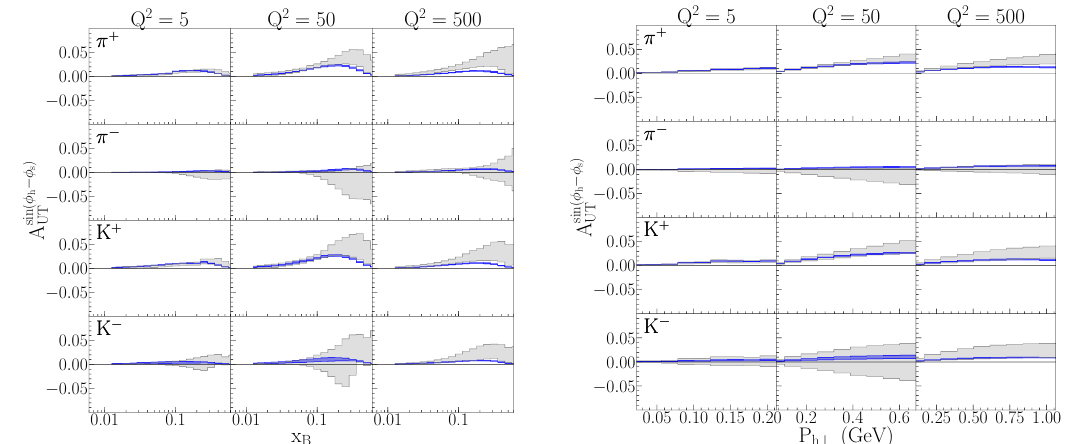
√ Figure 21 . The prediction for the EIC at S = 105 GeV. Left: the x B dependent prediction at z h = 0 . 5 and q ⊥ /Q = 0 . 2 . Right: the P h ⊥ dependent prediction at x B = 0 . 2 and z h = 0 . 25 . The blue band represents the prediction from the low energy extraction while the blue band represents the prediction from the η = 0